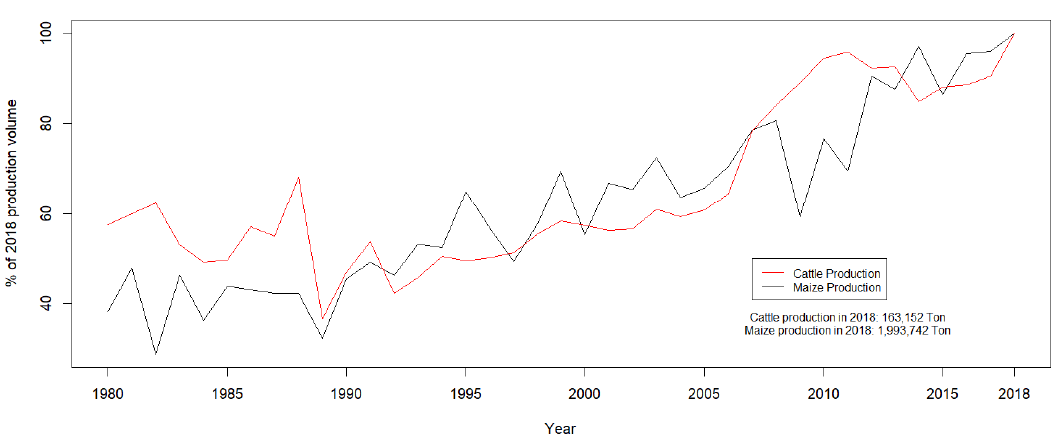
Figure 2. Cattle and Maize Production in Michoacán.